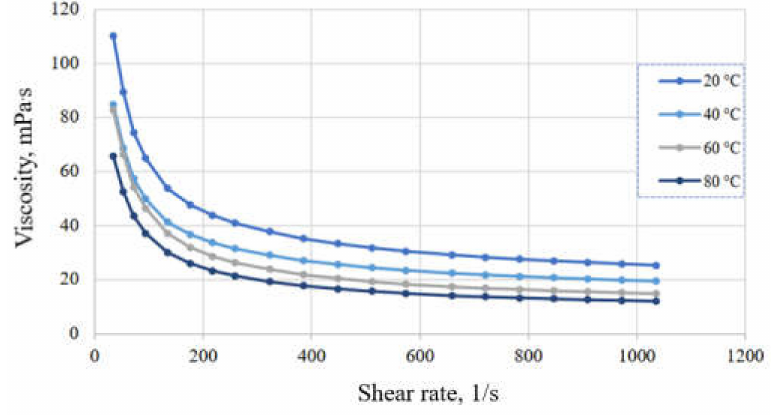
Figure 3. Dependence of viscosity on the shear rate for the formate-based drilling mud at different temperatures.